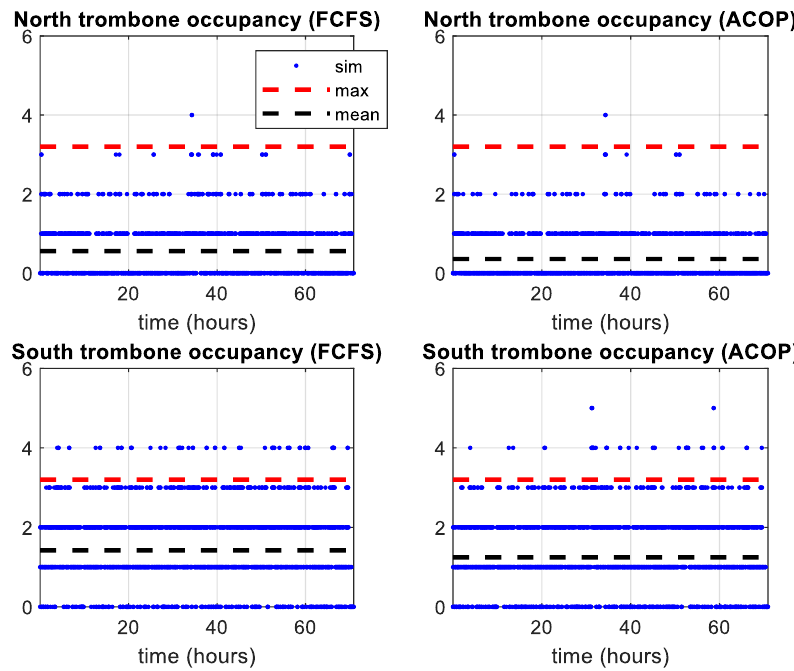
Figure 8. North and south trombones occupancies for FCFS and ACOP scenarios.